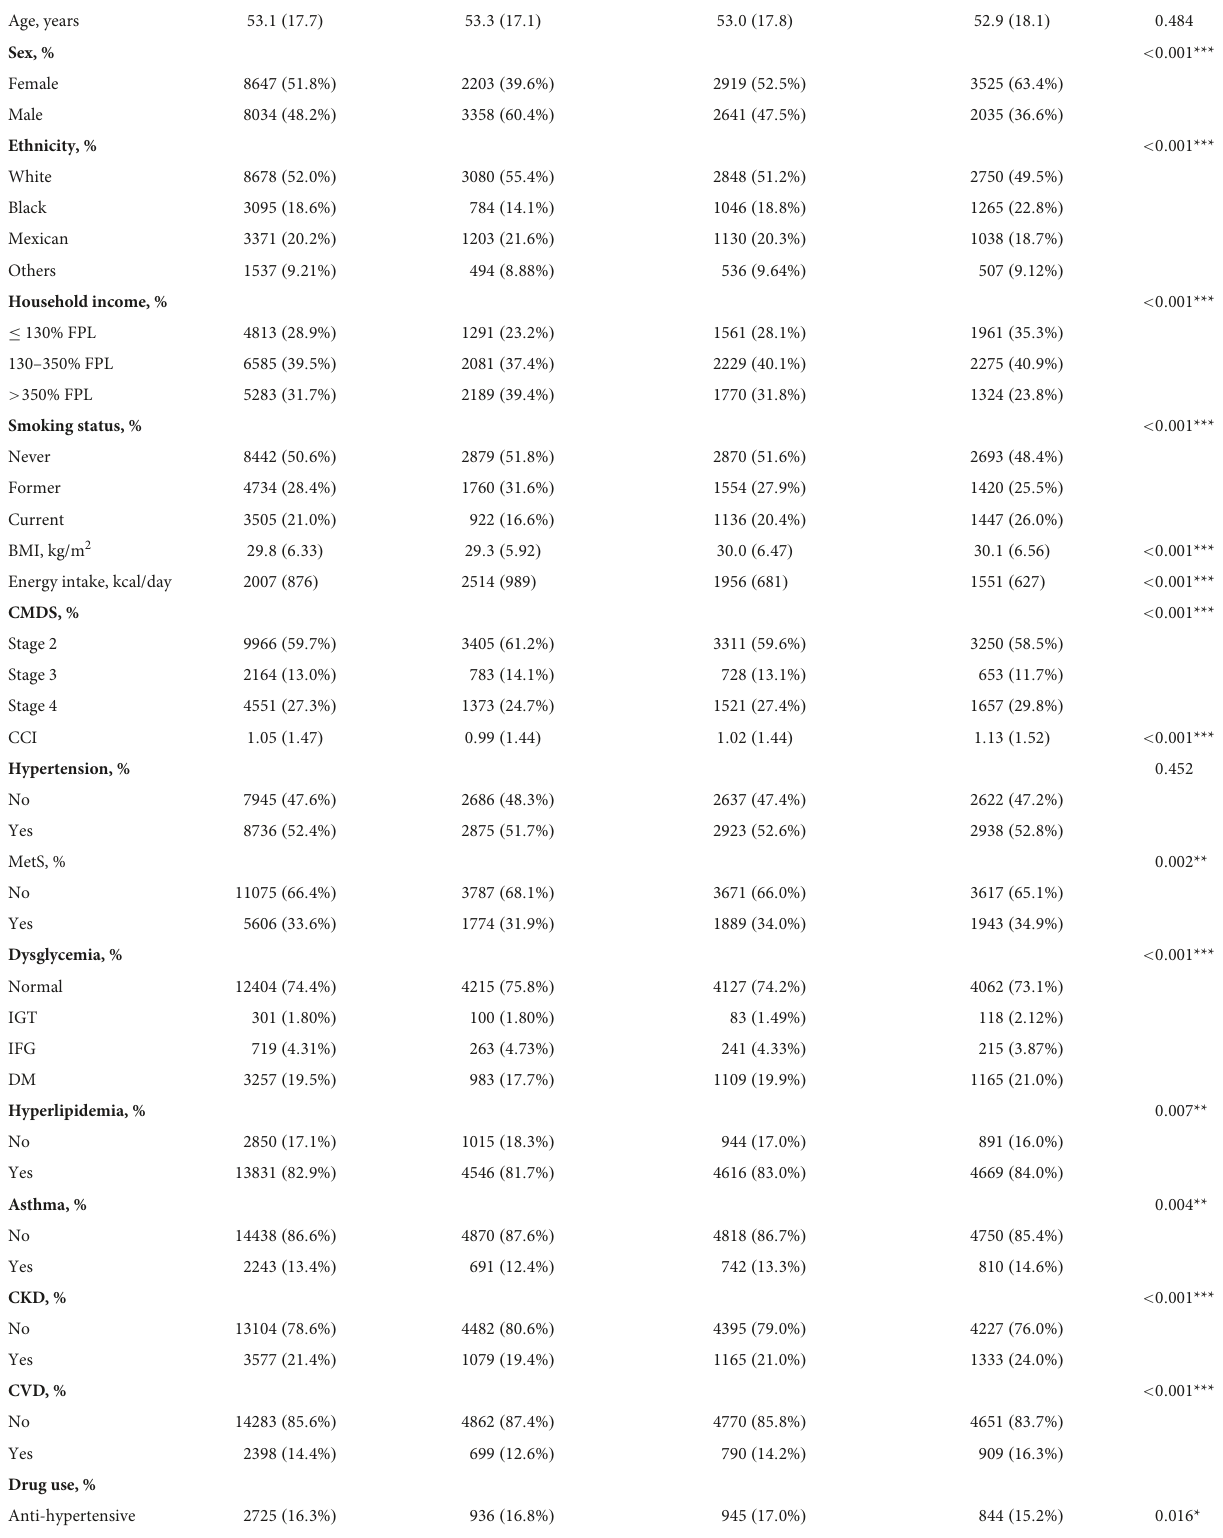
TABLE 1 Characteristics of participants across the tertiles of the dietary inflammatory index.